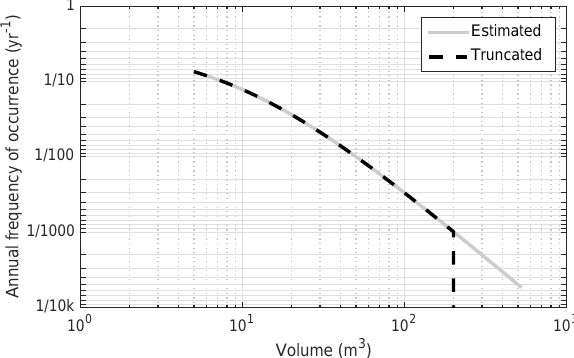
Figure 5. Volume–annual frequency of occurrence plot related to Becco dell’Aquila